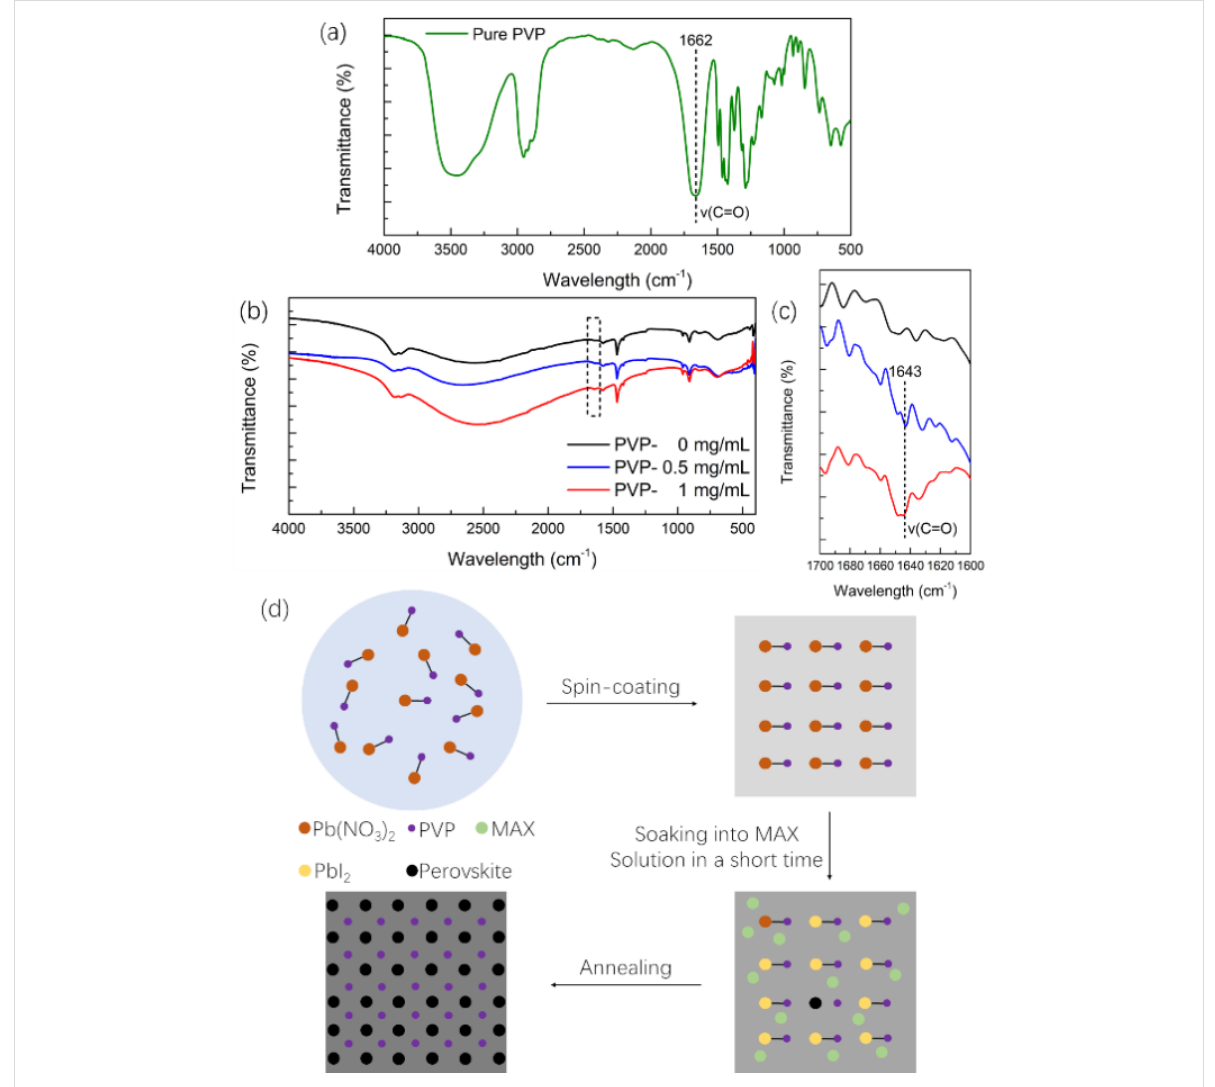
Figure 6: (a) Infrared spectrum of pure PVP over the full scan range. (b, c) Infrared spectra of the perovskite films; (b) full scan range and (c) expanded fingerprint region from 1700 to 1600 cm − 1 . (d) Schematic diagram and schematic reaction process of the deposition of perovskite films.